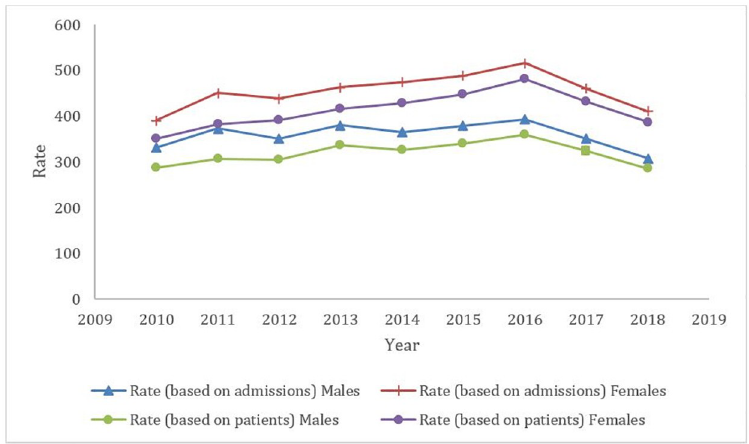
Fig 2. Rates of falls (per 100,000 population at risk) by sex, based on admissions and based on patients, between 2010 and 2018, in the Portuguese population.